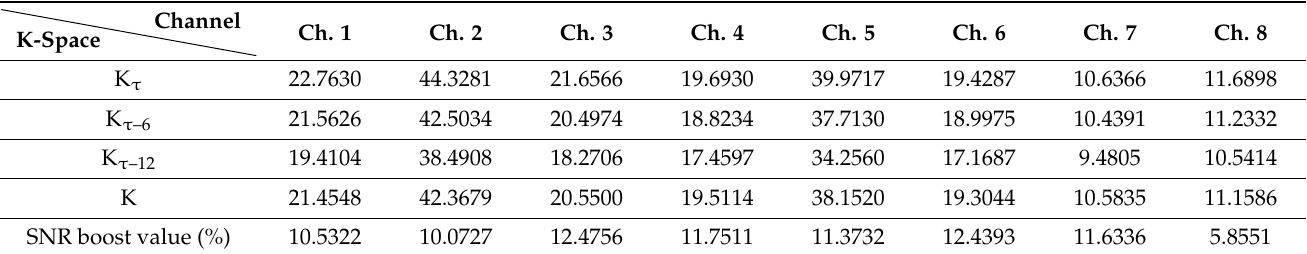
Table 1. Signal-to-noise ratio (SNR) improvement